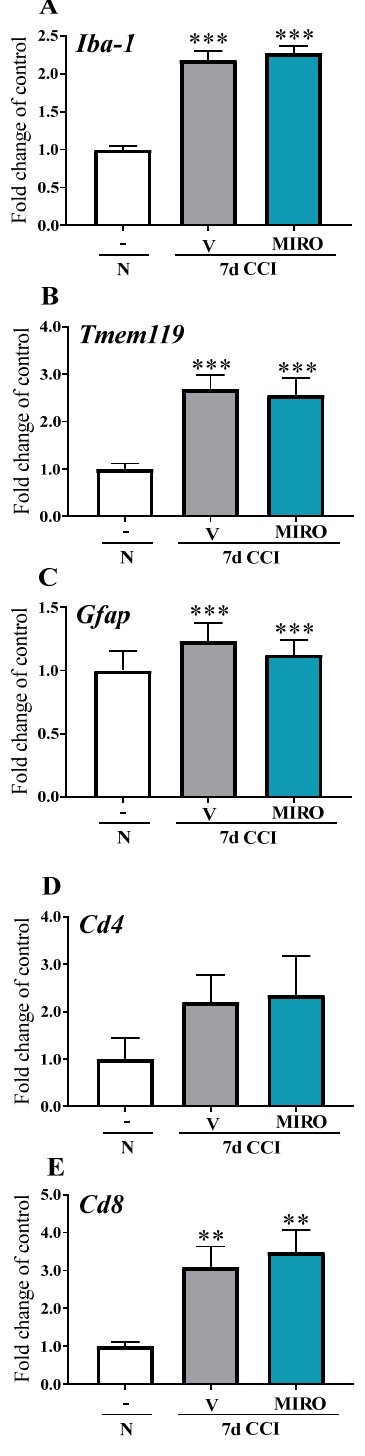
Figure 4. Effect of repeated intraperitoneal ( i.p. ) administration of mirogabalin (MIRO; 20 mg/kg) on Iba-1 ( A ), Tmem119 ( B ), Gfap ( C ) Cd4 ( D ) and Cd8 ( E ) mRNA levels in the spinal cord on day 7 post-CCI in mice. The data for the biochemical studies were analysed as fold changes compared with the controls and represent the normalized averages derived from the RT-qPCR threshold cycles of 5–10 samples from each group. Intergroup differences were analysed based on one-way ANOVA with Bonferroni’s multiple comparisons post hoc test. ** p < 0.01; *** p < 0.001 indicate a significant difference compared with the naïve group. Abbreviations: N—naïve, V—vehicle; MIRO—mirogabalin.